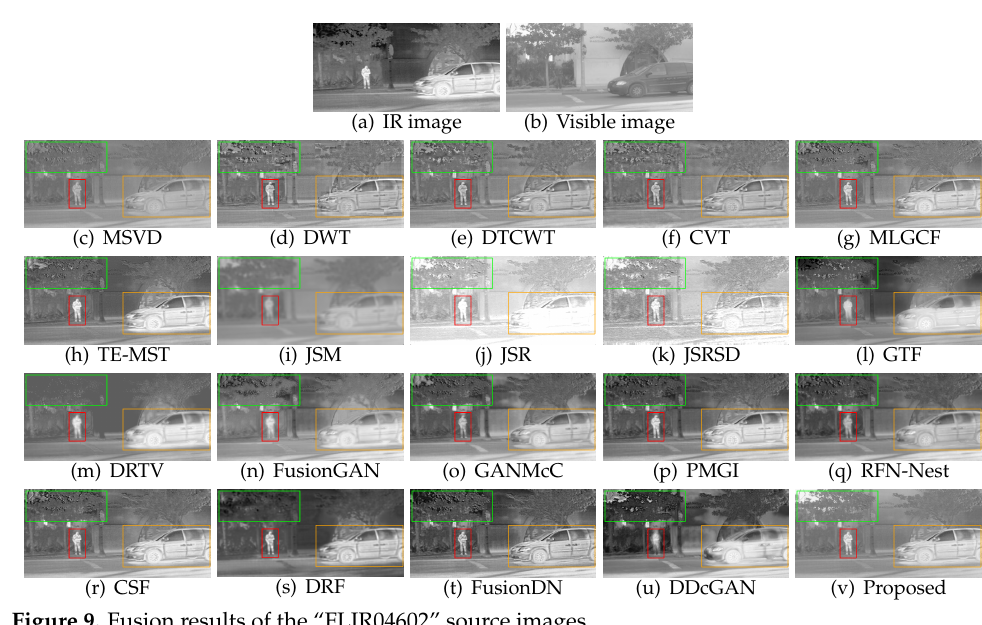
Figure 9. Fusion results of the “FLIR04602” source images.